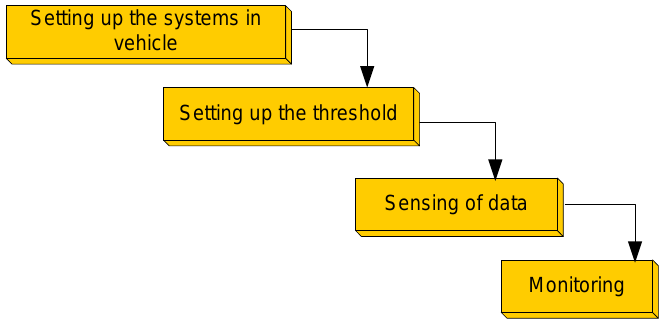
Figure 6. Model of the proposed system.